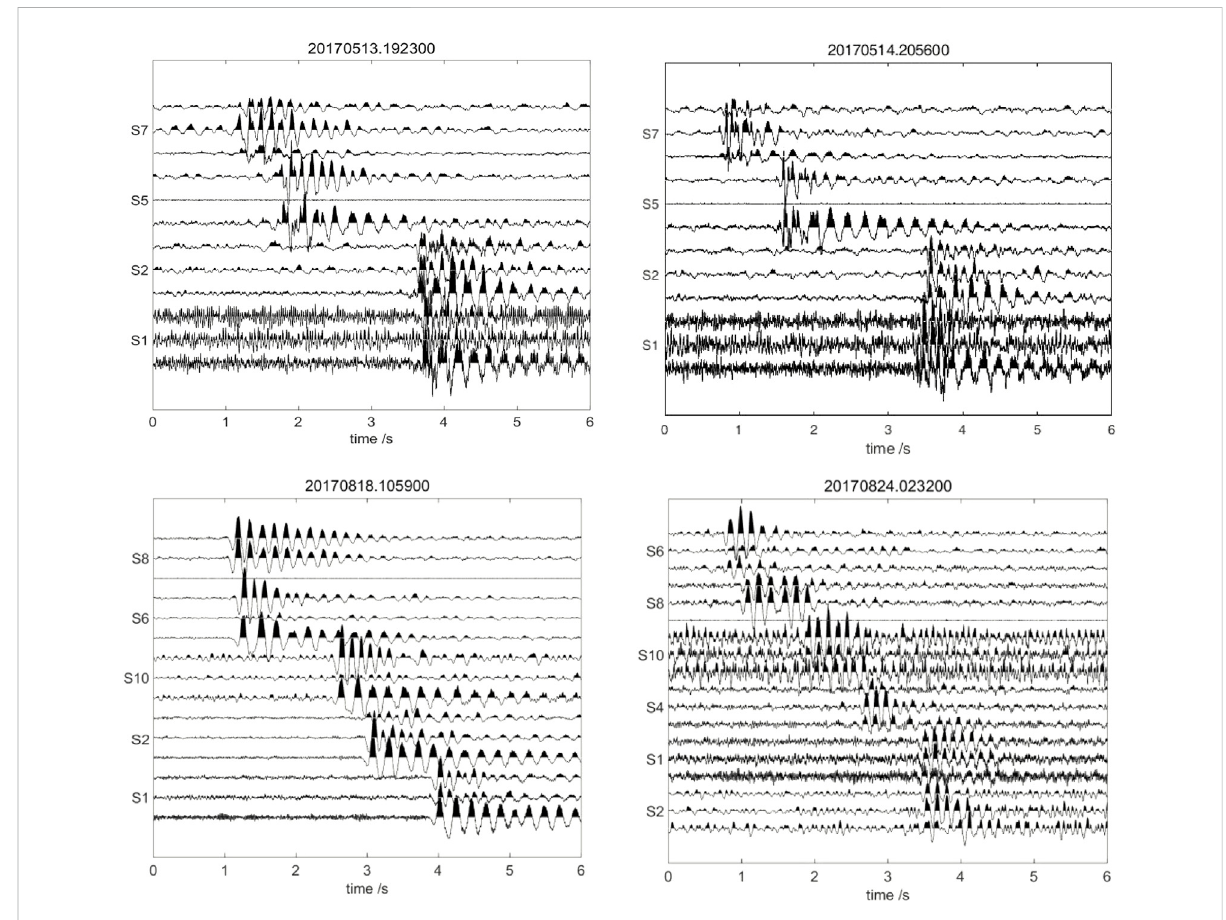
FIGURE 5 The second event waveforms for four paired signals in Figure